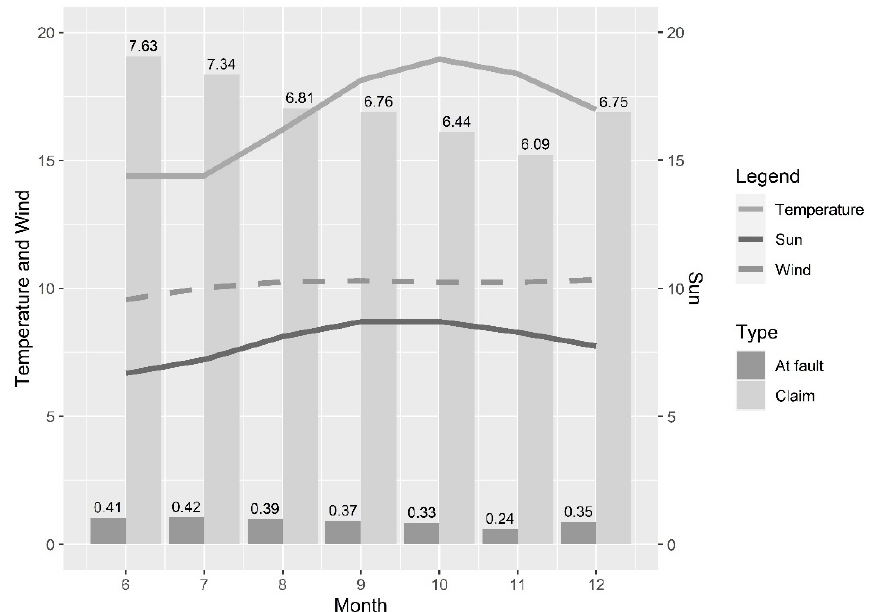
Figure 3. Percentage monthly frequency of claims (light grey) and percentage of at-fault third-party liability frequency of monthly claims from month 6 to month 12. The monthly average temperature in degrees Celsius (scale on the left axis) and monthly average wind speed in km/h (scale also on the left axis) are plotted, together with the average monthly sunshine daily hours (scale on the right axis). Table 2. Cross-table with the total number of claims (rows) and at-fault third-party liability (TPL) claims (columns) per insured during the seven observed months in 2018 and